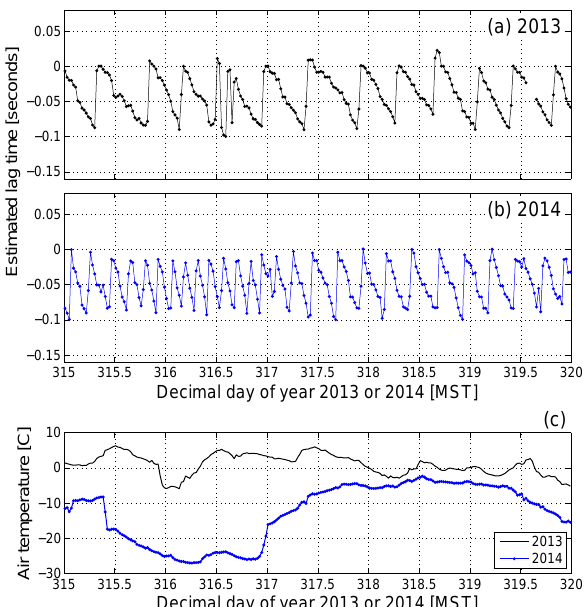
Figure 9. A 30min time series of the time lag estimated from the phase spectrum between the analog and digital signal of the CO 2 dry mole fraction from the EC155 IRGA for (a) 2013 and (b) 2014. In (c) , the 21.5m air temperature from both years is shown (see legend). The analog voltage is ingested into the data system by the FAST CR23X data logger, while the digital signal is archived on a CR3000 connected to the EC155. A negative sign indicates that the analog signal lags behind the digital